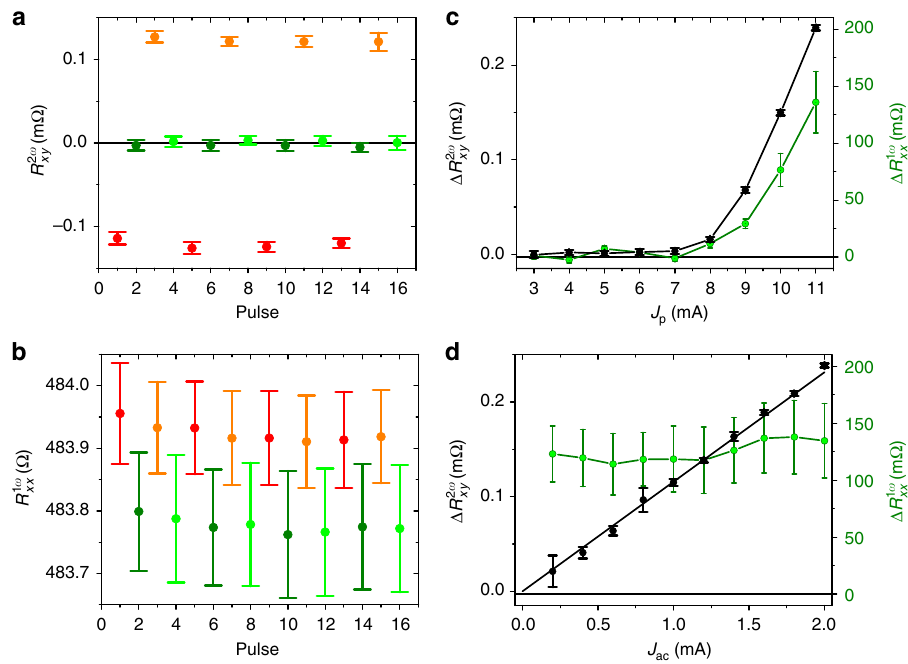
Fig. 4 Comparison of second- and fi rst-harmonic signals. a Second-harmonic R 2 ω xy signal measured for four sequences of writing pulses along + y , + x , − y , − x directions. b Same writing sequences as in a probed with the fi rst-harmonic R 1 ω xx . c First- and second-harmonic signals measured as a function of the amplitude of the writing current pulse. d Dependencies of the fi rst- and second-harmonic signals on the probing current J ac . Probing signals are averaged over 30 s detection time starting 5s after the writing pulse and error bars in a – d correspond to the standard